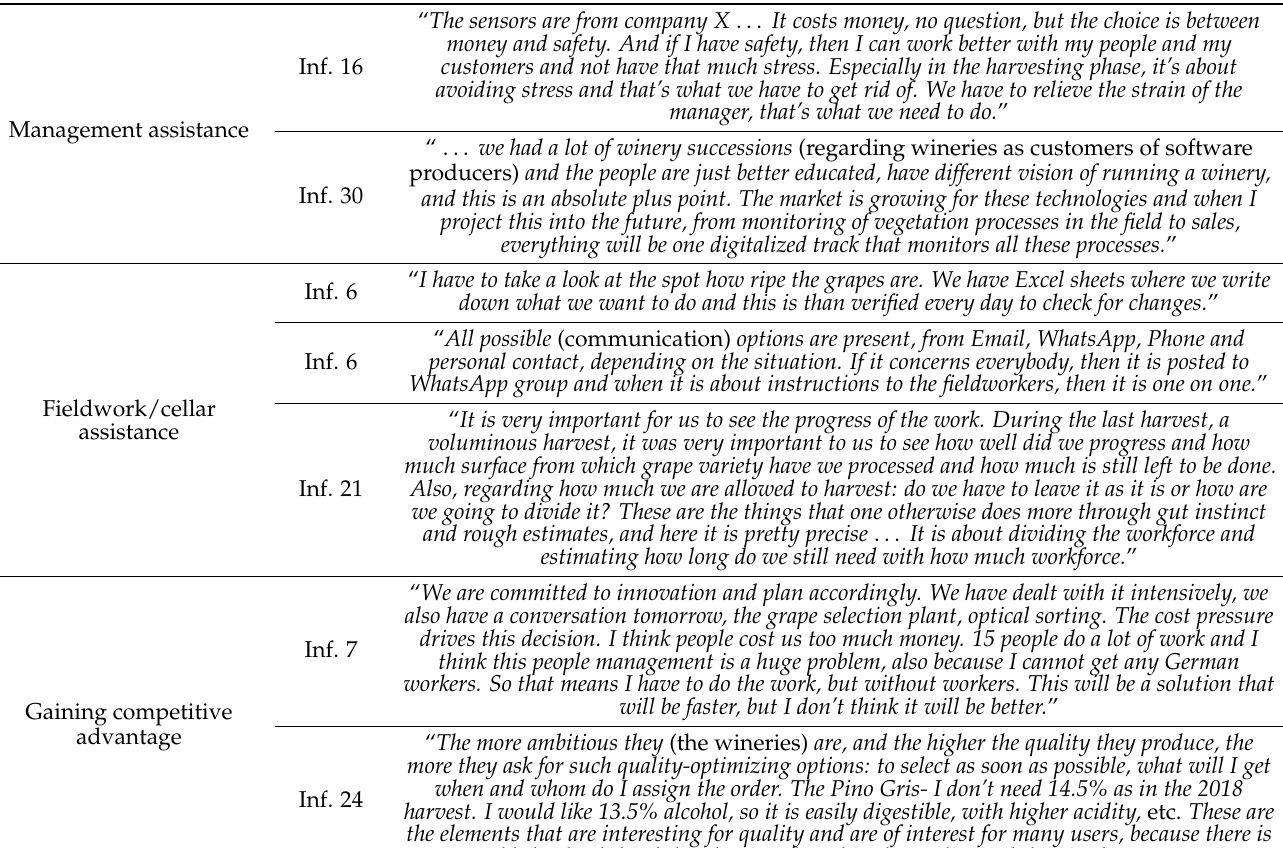
Table 2. Verbatim codes for challenges fueling the pull, servitization strategies of wine